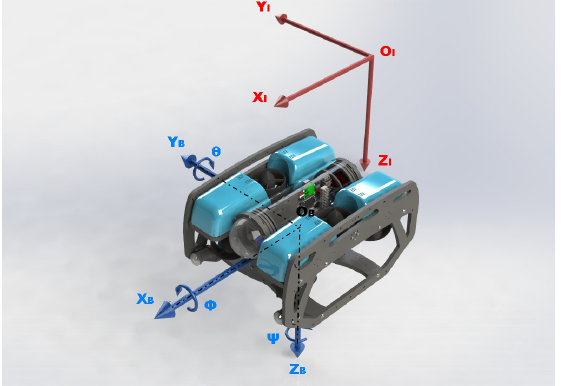
Figure 1. Reference frames: inertial (red) and body-fixed